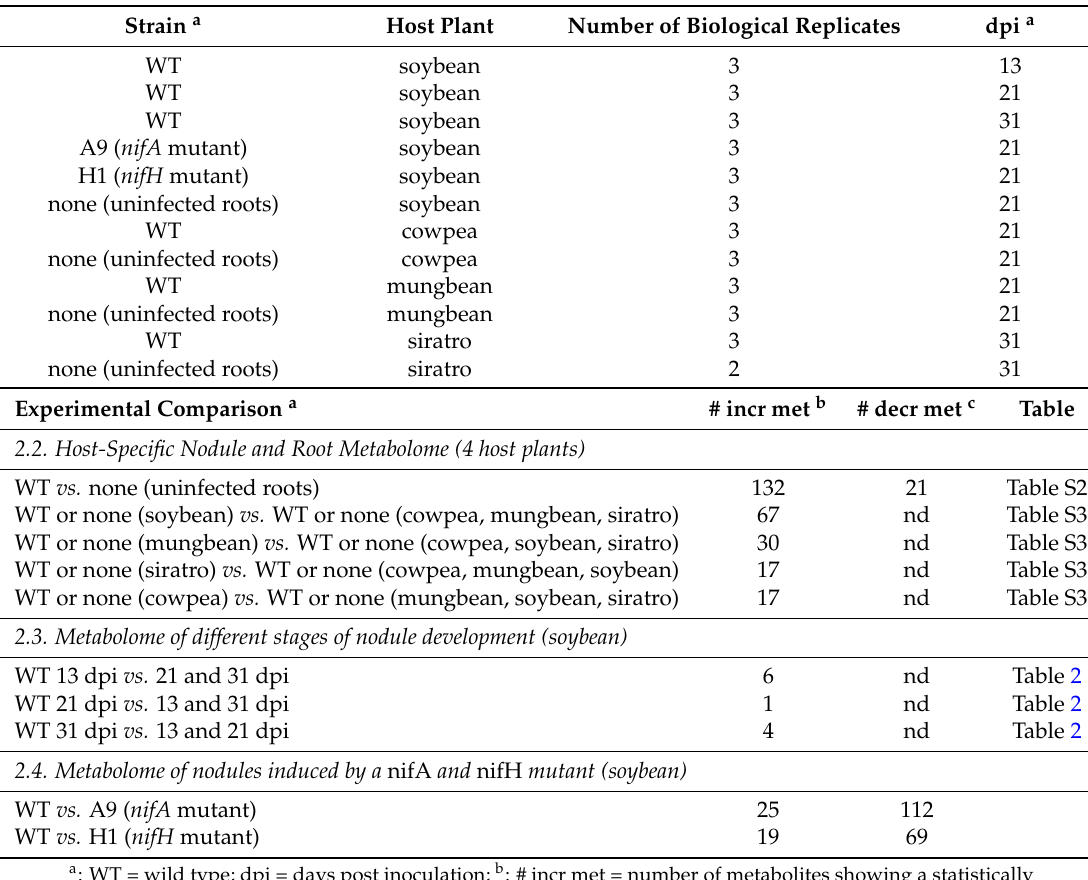
Table 1. Overview of experiments and summary of comparative non-targeted metabolome analyses performed in this study using flow injection time-of-flight mass spectrometry. Strain a Host Plant Number of Biological Replicates WT soybean WT soybean